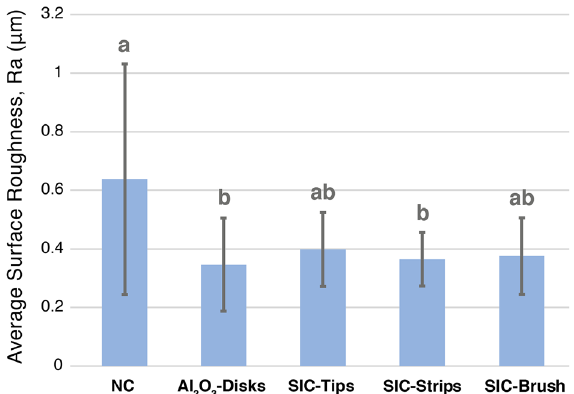
Figure 3. Means and standard deviations of average surface roughness (Ra) of enamel after use of the different polishing protocols.